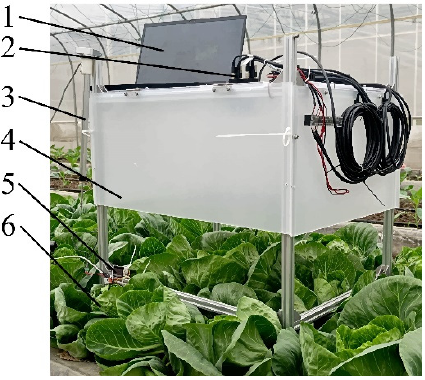
Figure 14. Accuracy test platform site. Key: 1. visual processing platform; 2. binocular camera with an 850 nm filter; 3. linear displacement sensor; 4. fixed support frame; 5. digital display for displacement sensor; 6. cabbage.